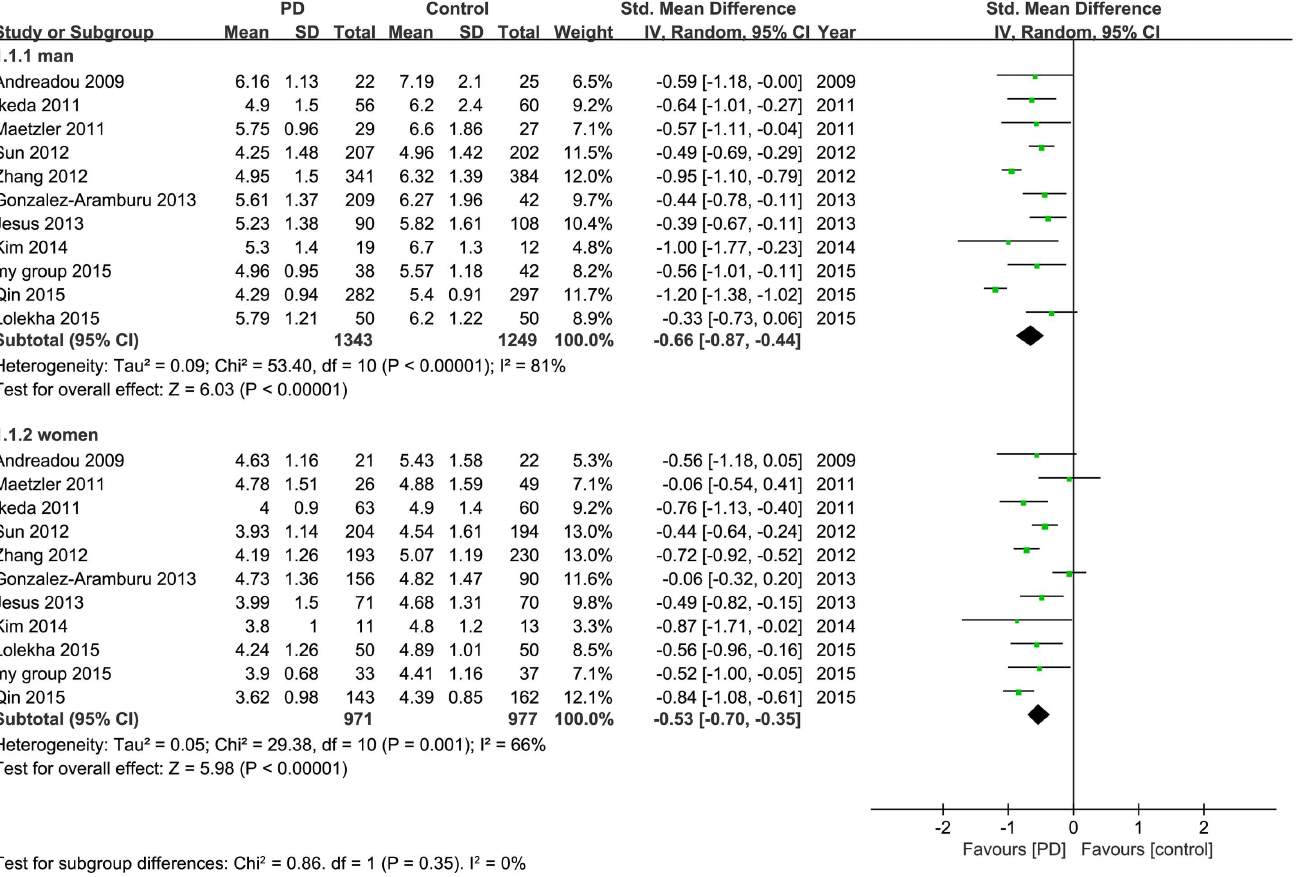
Fig 4. Forest plot of serum uric acid levels in PD compared to control in men and women.